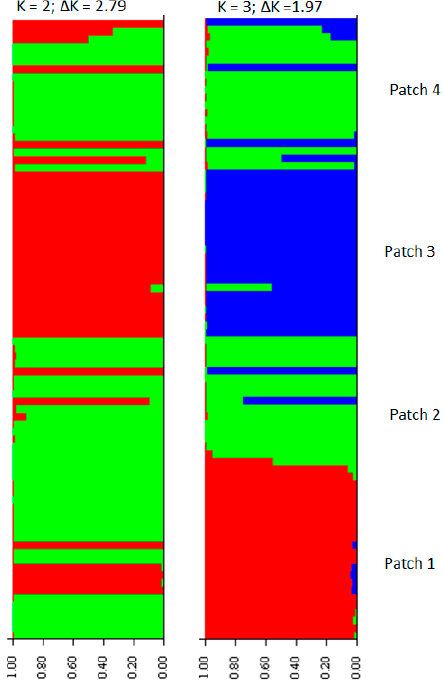
Figure 2. Genetic structure of the individuals into 2 and 3 genetic groups. The highest value of Δ K is estimated for K = 2. In K = 3, an unweighted pair group method arithmetic average (UPGMA) analysis confirmed the clustering of the individuals of patch 3. Potential migration of alleles among patches is visualized by entire or partial intercalated bars.